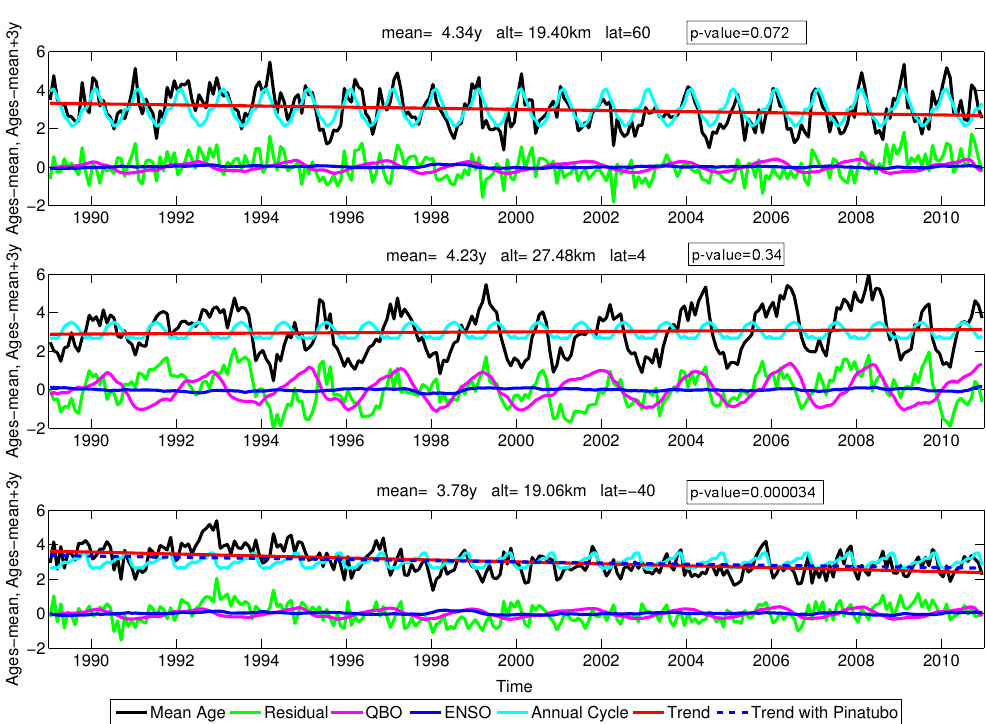
Fig. 14. Temporal evolution of the different components of mean age at several heights and latitudes. (Upper): 20km and 60 ◦ N, (Mid): 28km and 4 ◦ N, (Lower): 20km and 40 ◦ S. (Black): mean age over 22-yr period. (Green): residual of the least squares method. (Magenta): amplitude of the QBO component. (Blue): amplitude of the ENSO component. (Cyan): annual cycle of the mean age. (Red): trend of the mean age derived from the least squares method. (Dash blue): trend of the mean age derived from the least squares method after removal of the Pinatubo years. The p -value of the trend is shown in a box for each panel.